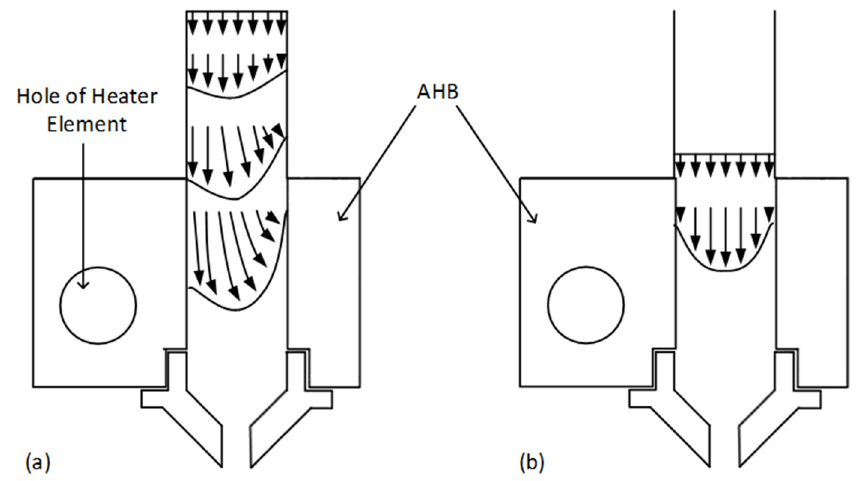
Figure 9. Schematic flow-velocity profile of ( a ) uncoated AHB and ( b ) coated AHB. The minimum surface temperatures between the layers of coated AHB are given in Figure 10. Through the literature, it was found that the surface temperature (T s ) of AHB was reduced by the thermal barrier [26]. By reducing the difference between the surface